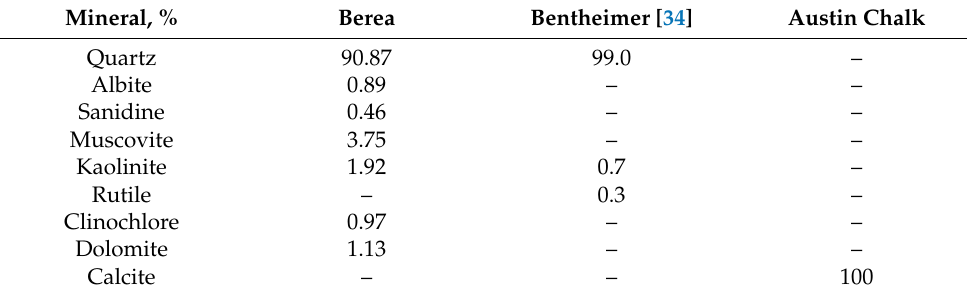
Table 2. Mineral composition of rock samples by